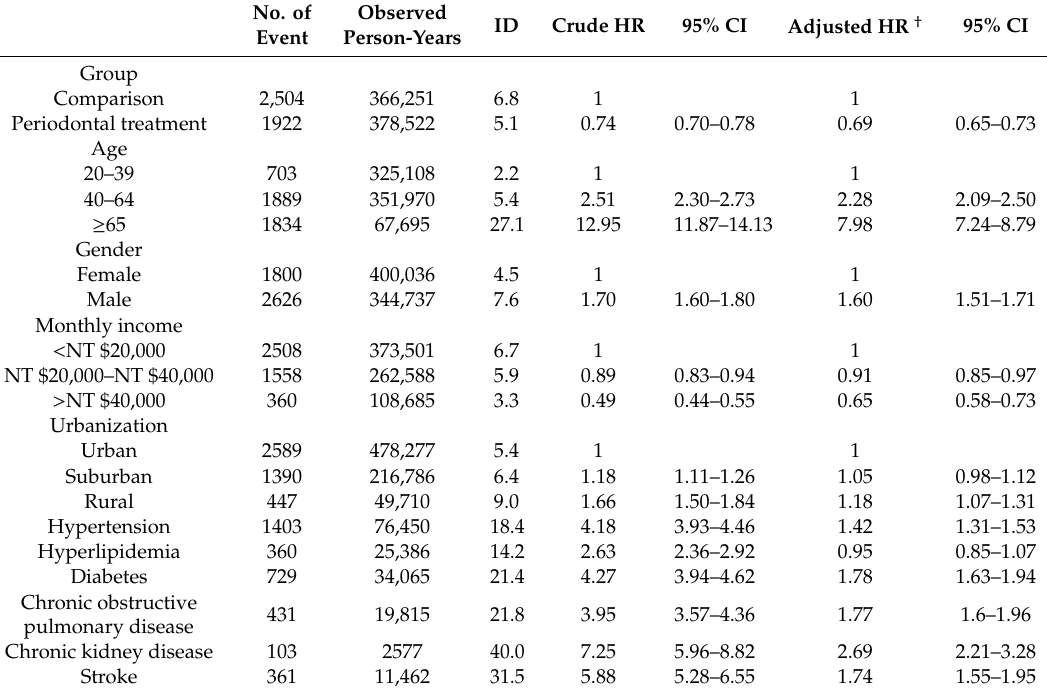
Table 2. Risk factor analysis of pneumonia